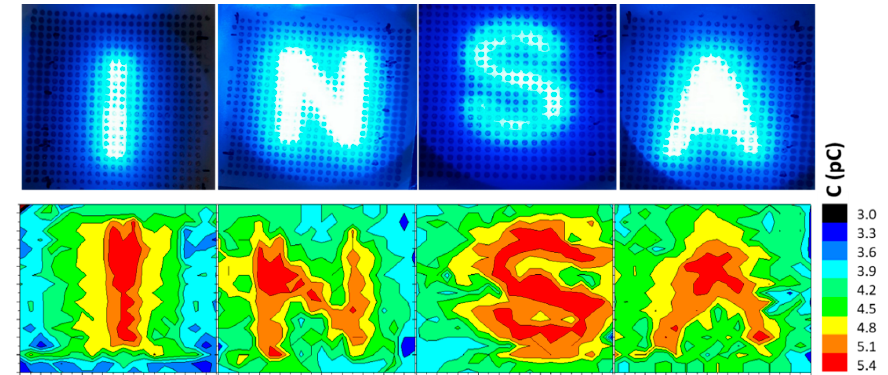
Figure 10. Schematic illustration corresponding to the capacitance measurement of flexible photocapacitor arrays.